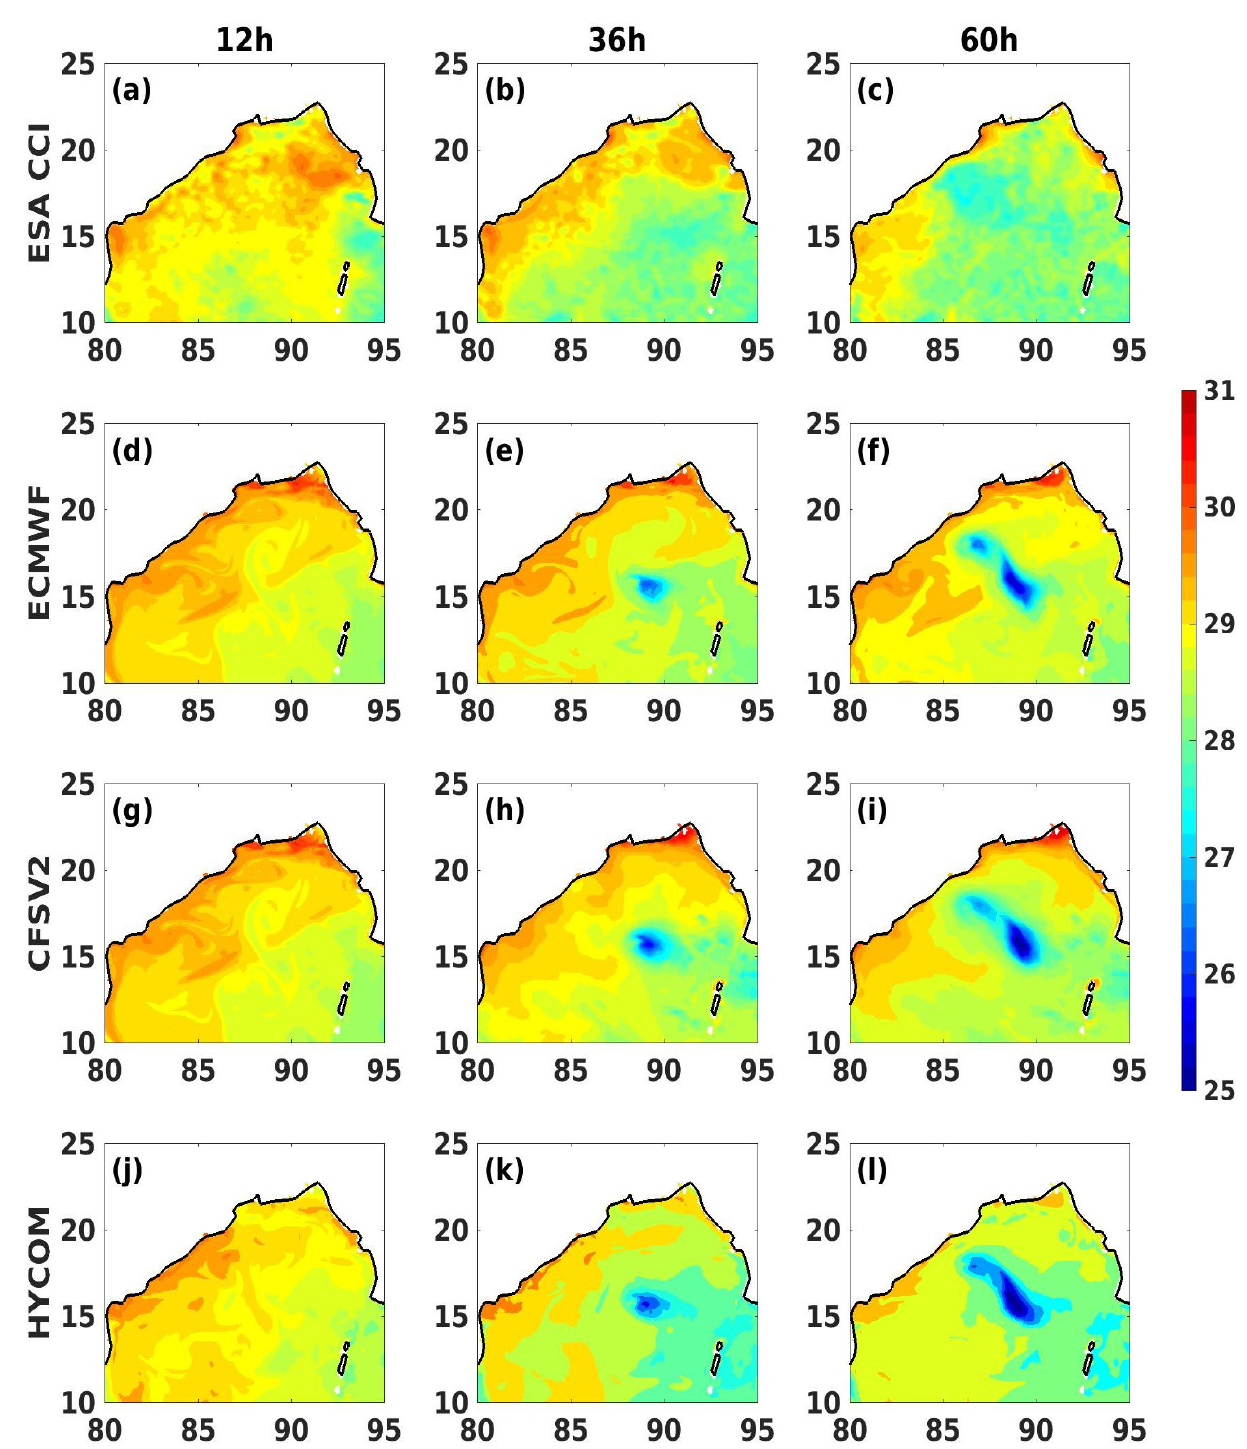
Figure 5. Spatial distribution of SST (°C) as obtained from ESA CCI observations ( a – c ) and the three experiments (( d – f ) ECMWF, ( g – i ) CFSV2, ( j – l ) HYCOM) at 24 h intervals between 12 and 60 h.